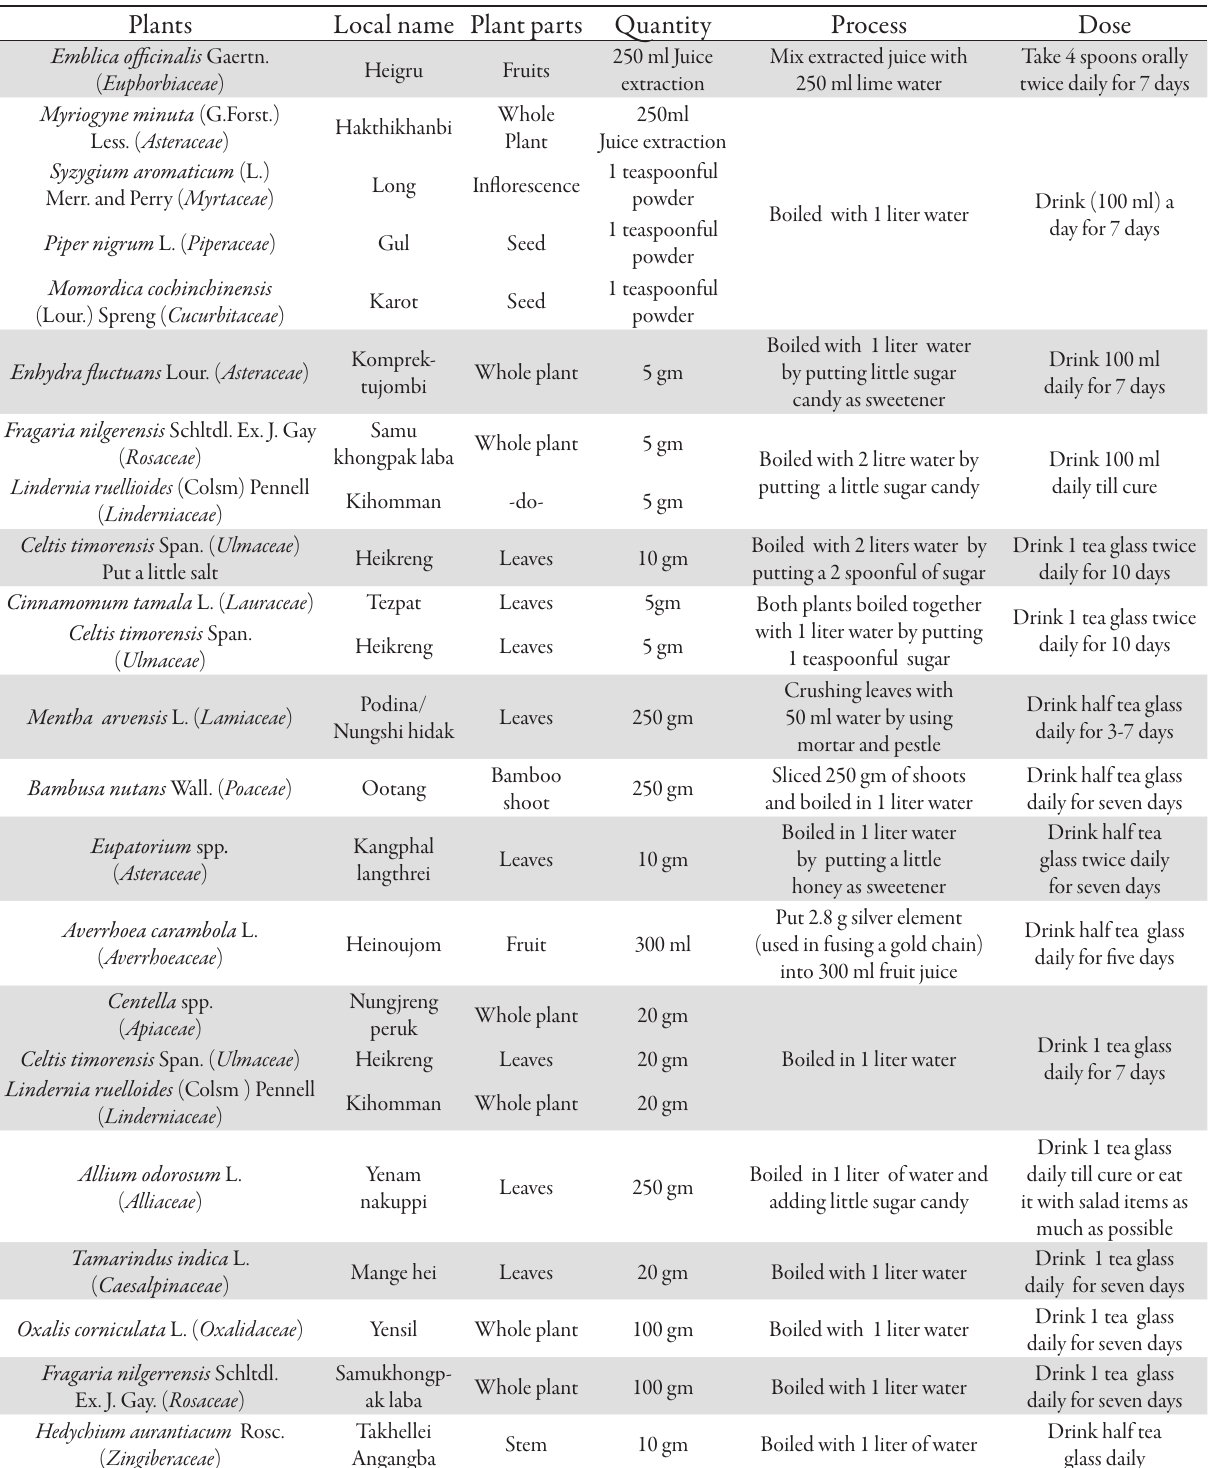
Tab. 1. Traditional herbal treatment methods of kidney stones by Muslim herbalists Plants Local name Plant